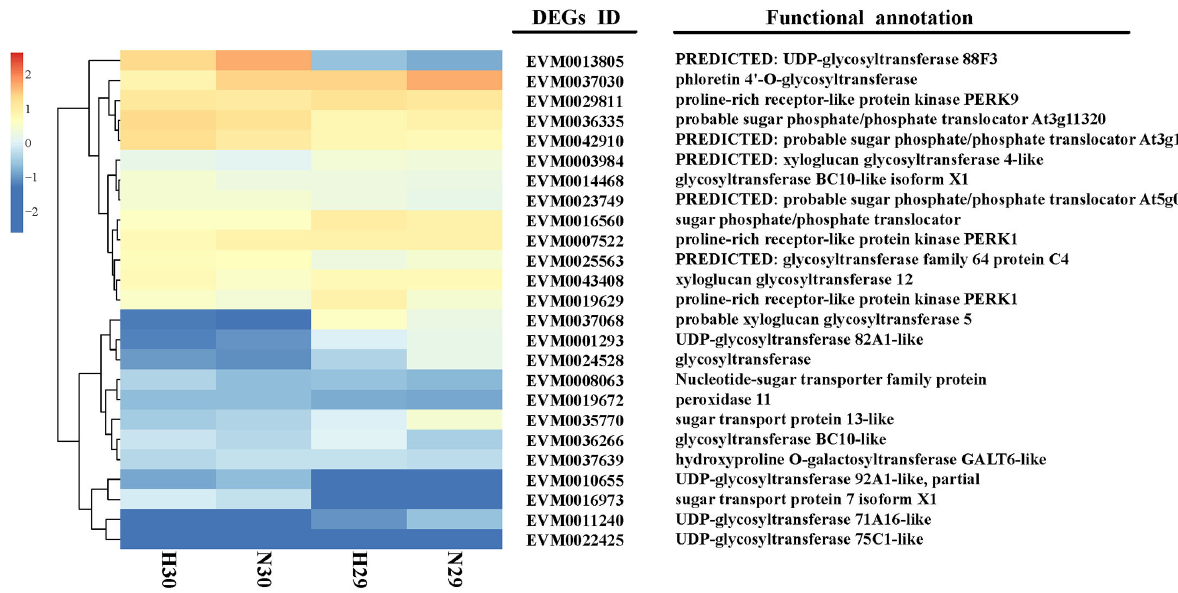
FIGURE 7 | Heatmap and functional annotation of 25 DEGs related to cold resistance indicators.